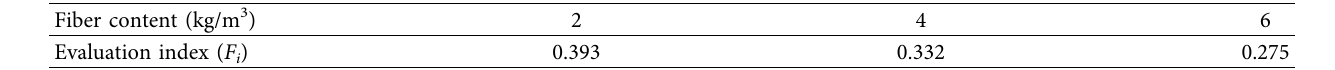
Table 12: Calculation results of evaluation index for diferent basalt fber